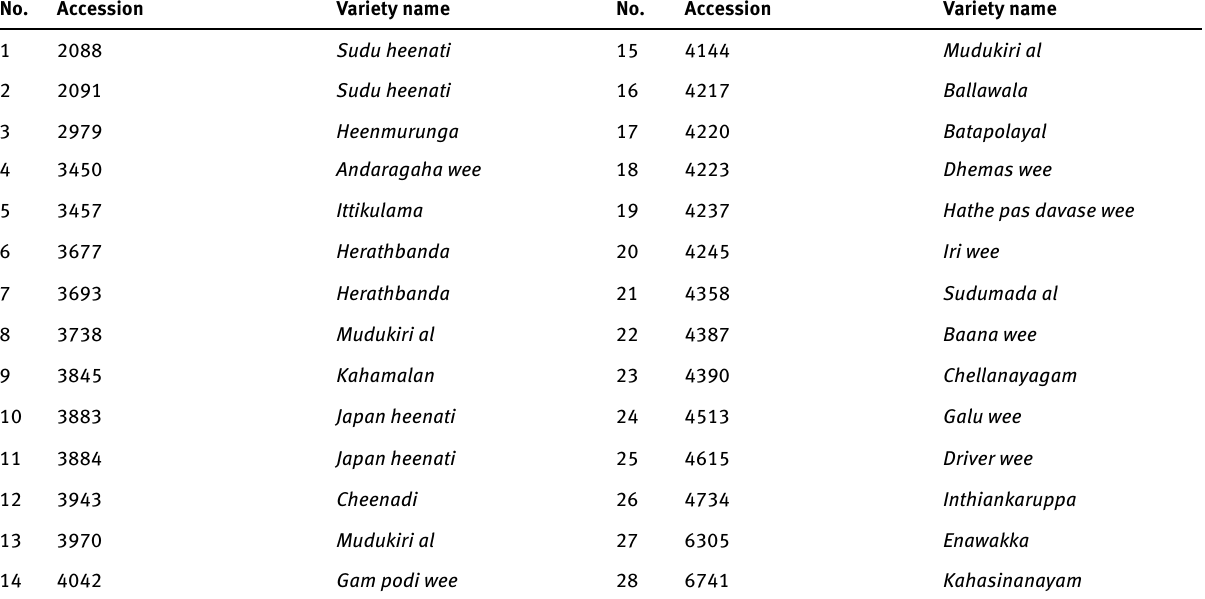
Table 1: Selected traditional rice